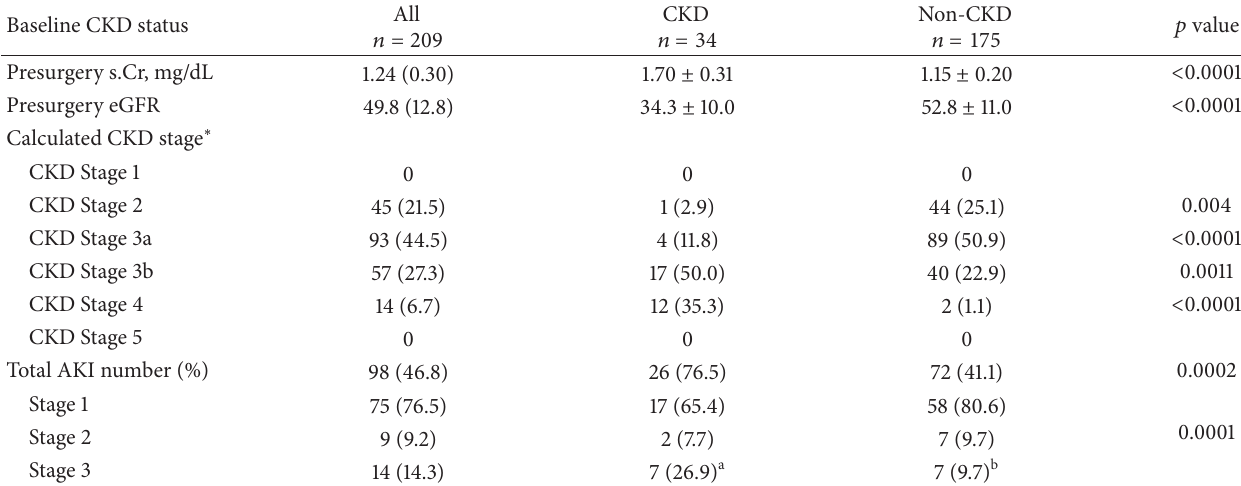
Table 2: AKI occurrence and severity in CKD and non-CKD patients.